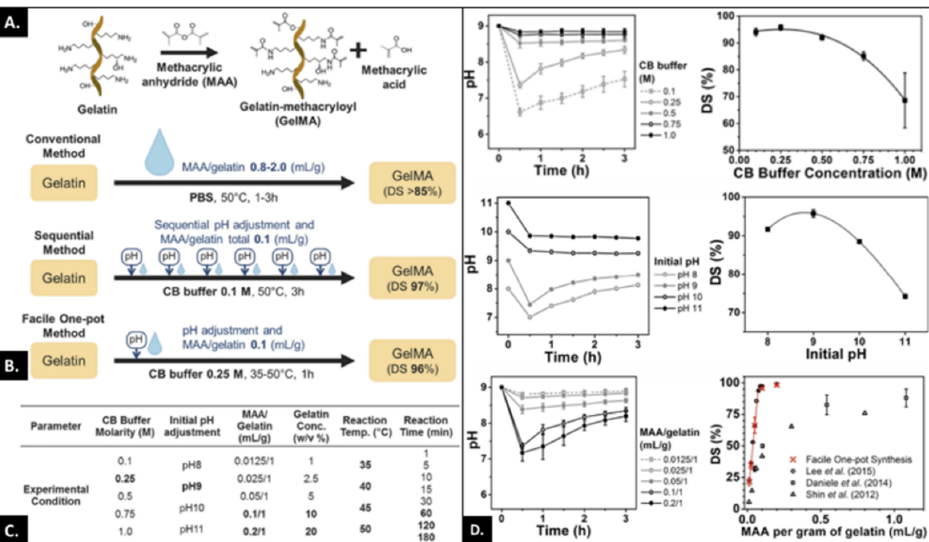
Figure 2. ( A ) Schematic illustration of GelMA synthesis. ( B ) represents different synthesis processes adapted with their corresponding DS (degree of substitution). The conventional method involves adding a large amount of methacrylic anhydride (MAA), but sequential addition requires less amount of MAA and pH adjustments to achieve higher DS. The other method relies on one-pot synthesis where high DS is achieved. ( C ) represents different experimental conditions tested and the corresponding reaction times. Letters/numbers in bold represent optimum conditions. ( D ) The graphs on the left represent pH changes during reaction conditions whereas the graphs on left represent DS as a function of molar concentration of CB (carbonate buffer), initial pH and MAA/gelatin ratio. Error bars represent the relative standard deviation of n = 3. Adapted with permission from Ref. [30]. Copyright 2016, Springer Nature.